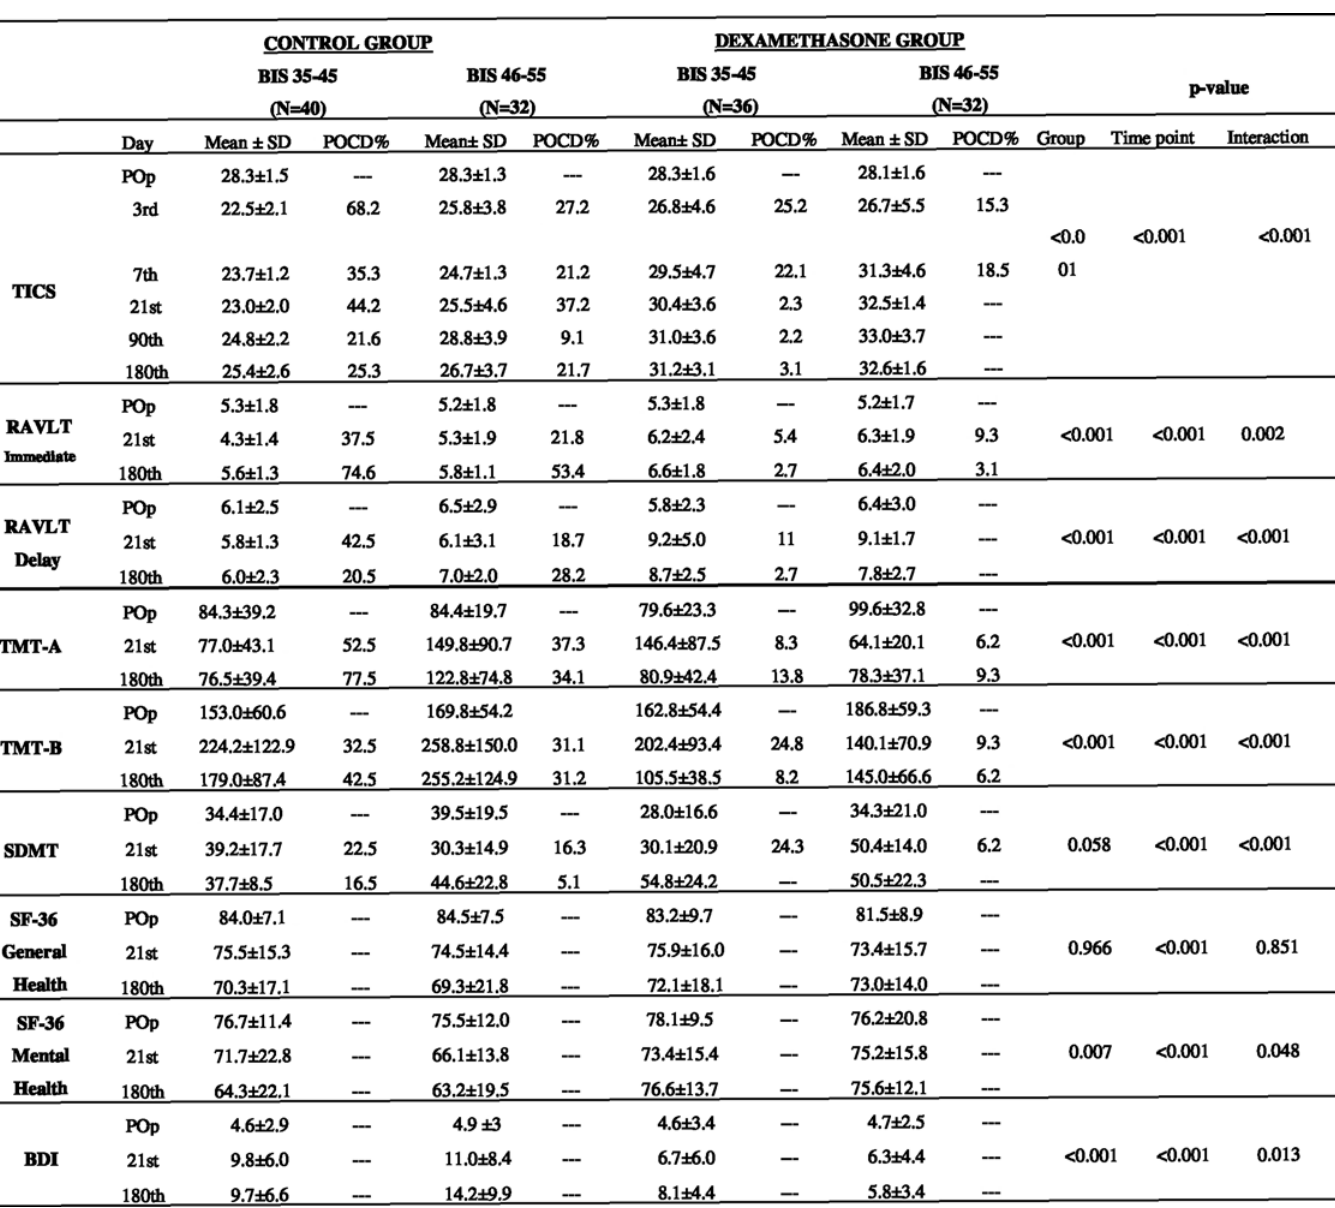
Fig 1. Pre and postoperative results of the specific test: for global cognitive, memory, attention, executive functions, and Quality of life and depressive symptoms, compared to normative data a . BIS: bispectral index; POCD: postoperative cognitive disorder; TICS: Telephone interview for cognitive status; RAVLT immediate: Rey Auditory- verbal learning test (immediate); RAVLT delay: Rey Auditory- verbal learning test (delay); TMT-A: Trail making test- A; TMT-B: Trail making test-B; SDMT: symbol digit modalities — Test; SF-36 general health: Short form health survey (general health); SF-36 Mental Health: Short form health survey (mental health); BDI: Back depression inventory. a Normative values. Data are mean ± SD and percentage for patients with POCD. TICS: 27 ± 3; VLT: immediate 6.3 ± 2.1; delay 10.2 ± 2.5; TMT-A (cid:1) 55 and TMT-B (cid:1) 137; SDMT 50.1 ± 8.1; SF-36 scale > 60 ± 10; BDI < 12; Pop = Preoperative; Postoperative days = 3 rd ; 7 th ; 21 st ; 90 th and 180 th ; b * p -value for the Generalized Estimating Equations (GEE).